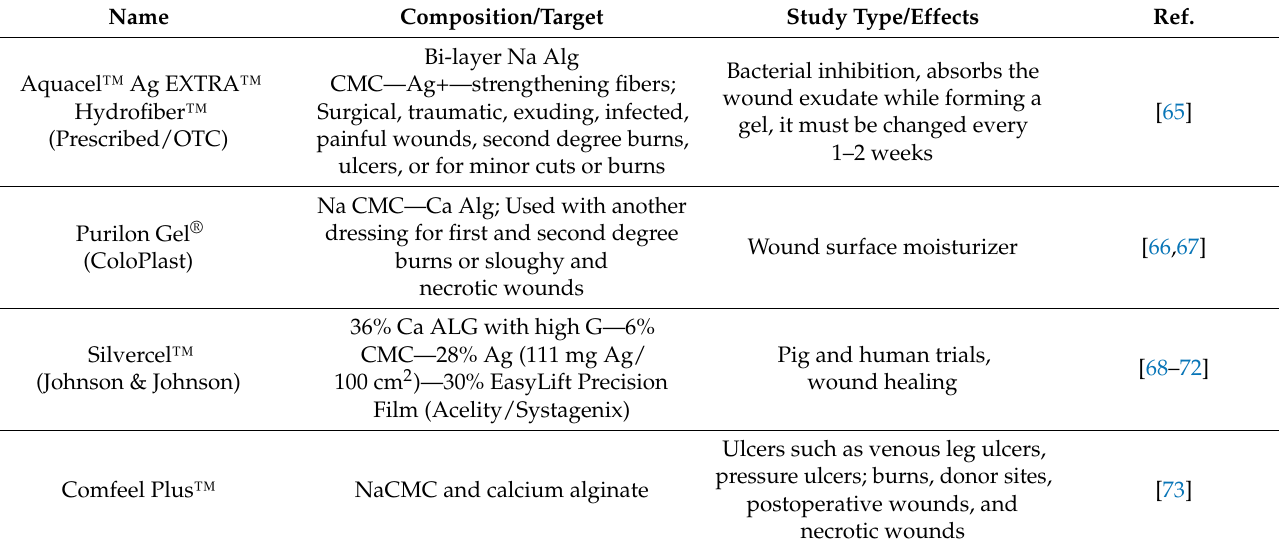
Table 2. Commercially available alginate–CMC products and their